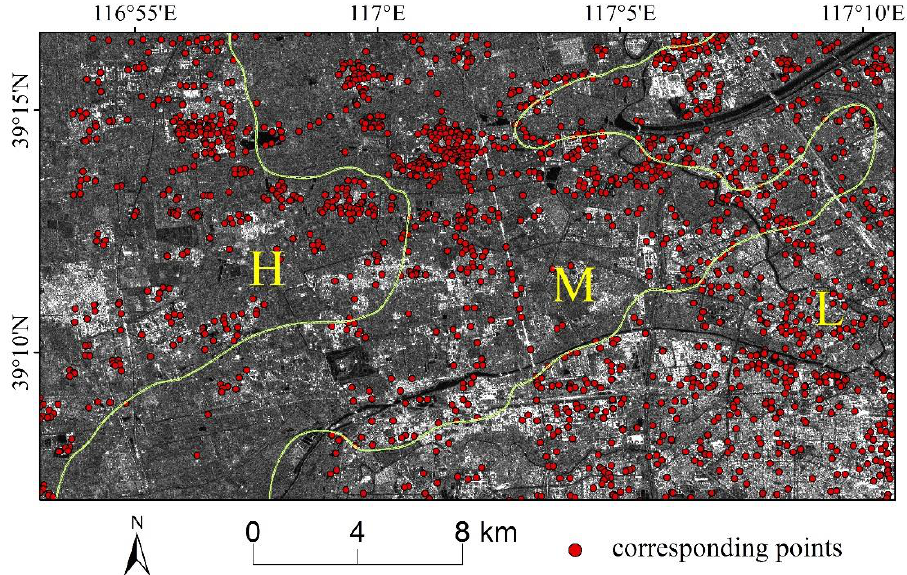
Figure 6. Corresponding points’ distribution of the two MT-InSAR methods, with the background of SAR intensity image of Sentinel-1A.